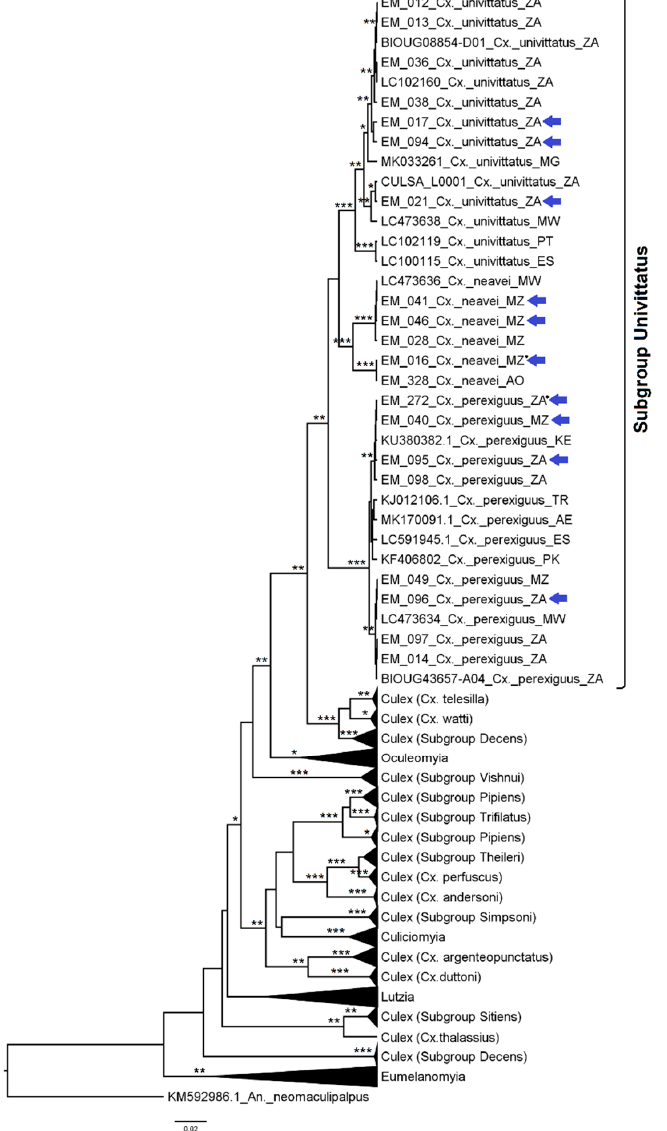
Figure 10. Phylogenetic analysis of 170 partial coxI nucleotide sequences from Culex and Lutzia mosquitoes, presenting the subgroup Univittatus. At specific branches, the number of * indicates the tree topological support revealed by the different phylogenetic reconstruction methods, assuming relevant bootstrap and aLRT values above 75% and posterior probability values above 0.80. The sequences obtained in this work are indicated by the “EM” code and those with associated genitalia are indicated by horizontal blue arrows. The sequences downloaded from GenBank and Boldsystems are indicated by their respective accession numbers and access codes (respectively); the symbol “.” After the code of our sequence indicates that said sequence was not identified by Boldsystems. Their country of origin [South Africa (ZA), Angola (AO), United Arab Emirates (AE), Spain (ES), Madagascar (MG), Malawi (MW), Mozambique (MZ), Pakistan (PK), Portugal (PT), Kenya (KE), Turkey (TR)] are also indicated. The vertical line marks the subgroup Univittatus; the collapsed branches are the species of the genus Lutzia and subgenera and/or informal groups of the genus Culex .